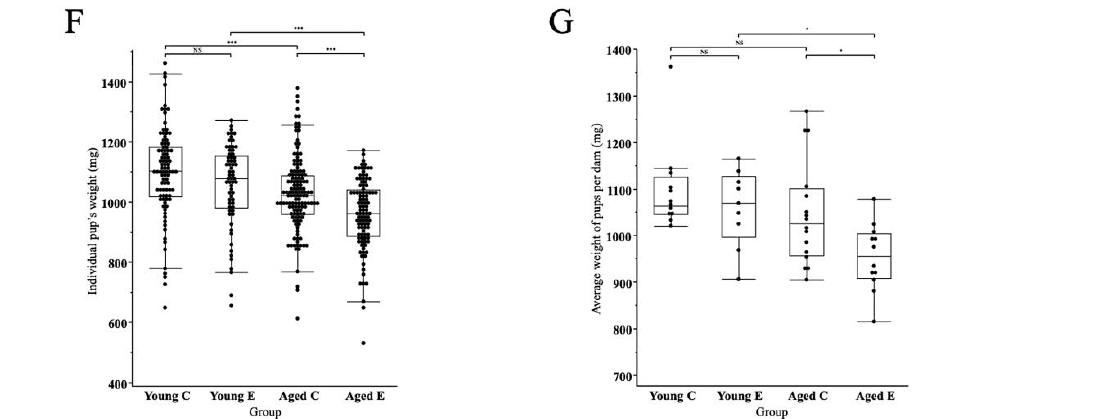
Figure 3. ( A ) A representative macroscopic image of the uterus, pups and placenta of a control mouse. The uterus was obtained at 18 dpc. Pups were cleaned from the uterus, pictured, and weighted. * indicates fetus in the uterus. ( B ) A representative macroscopic image of the uterus, pups, resorptions and placenta of an endometriosis mouse. The uterus was obtained at 18 dpc. Pups were cleaned from the uterus, pictured, and weighted. * indicates fetus in the uterus, yellow dotted circle is the lesion. ( C ) A box-and-whisker graph of litter size. Litter size was counted, and analyzed using the Wilcoxon test. Litter size was not significantly different between the groups. NS: p > 0.05. ( D ) A box and whisker graph of resorption. The number of resorptions was counted and analyzed using the Wilcoxon test. The number of resorptions was significantly higher in Aged E compared to Aged C while there was no difference between the other groups. NS: p > 0.05, *: p < 0.05. ( E ) A box-and-whisker graph of implantation site. The number of implantation sites was analyzed using the Wilcoxon test. Implantation sites were calculated as the sum of litter size and the number of resorptions. The number of implantation sites did not differ significantly between the groups. NS: p > 0.05 (Young C; n = 33, Young E; n = 29, Aged C; n = 47, Aged E; n = 39 for a, b, c). ( F ) A box- and-whisker graph of pup body weight. Body weights (BW) of pups were measured and analyzed using the Wilcoxon test. Pups with a litter size of ≤ 3 or ≥ 13 were excluded. BW did not differ significantly between Young C and Young E, while BW was significantly lower in Aged E compared to Aged C, lower in Aged E compared to Young E and lower in Aged C compared to Young C. NS: p > 0.05, ***: p < 0.0001 (Young C; n = 91, Young E; n = 65, Aged C; n = 133, Aged E; n = 103). ( G ) A box-and-whisker graph of average body weight of pups to one dam. The average body weight of pups (Av. BW) to one dam was calculated and compared using the Wilcoxon test. Dams with litter size ≤ 3 or ≥ 13 were excluded. Av. BW was not significantly different between Young C and Young E, but was significantly lower in Aged E compared to Aged C. In addition, Av. BW did not differ significantly between Young C and Aged C, but was significantly lower in Aged E compared to Aged E. NS: p > 0.05, *: p < 0.05 (Young C; n = 12, Young E; n = 9, Aged C; n = 16, Aged E; n =